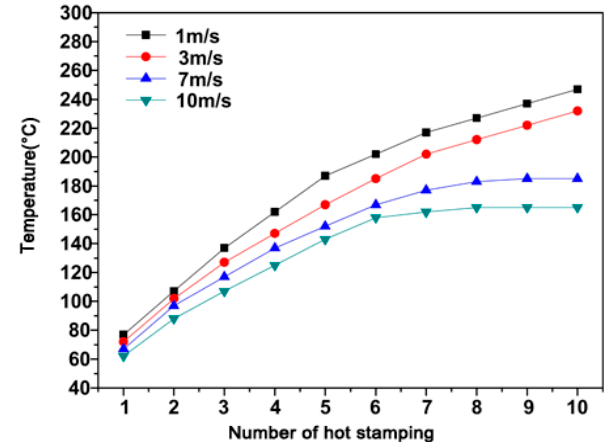
Figure 6. The relationships between predicted maximum temperature of the as-quenched blanks and the number of hot stampings under various air velocities.